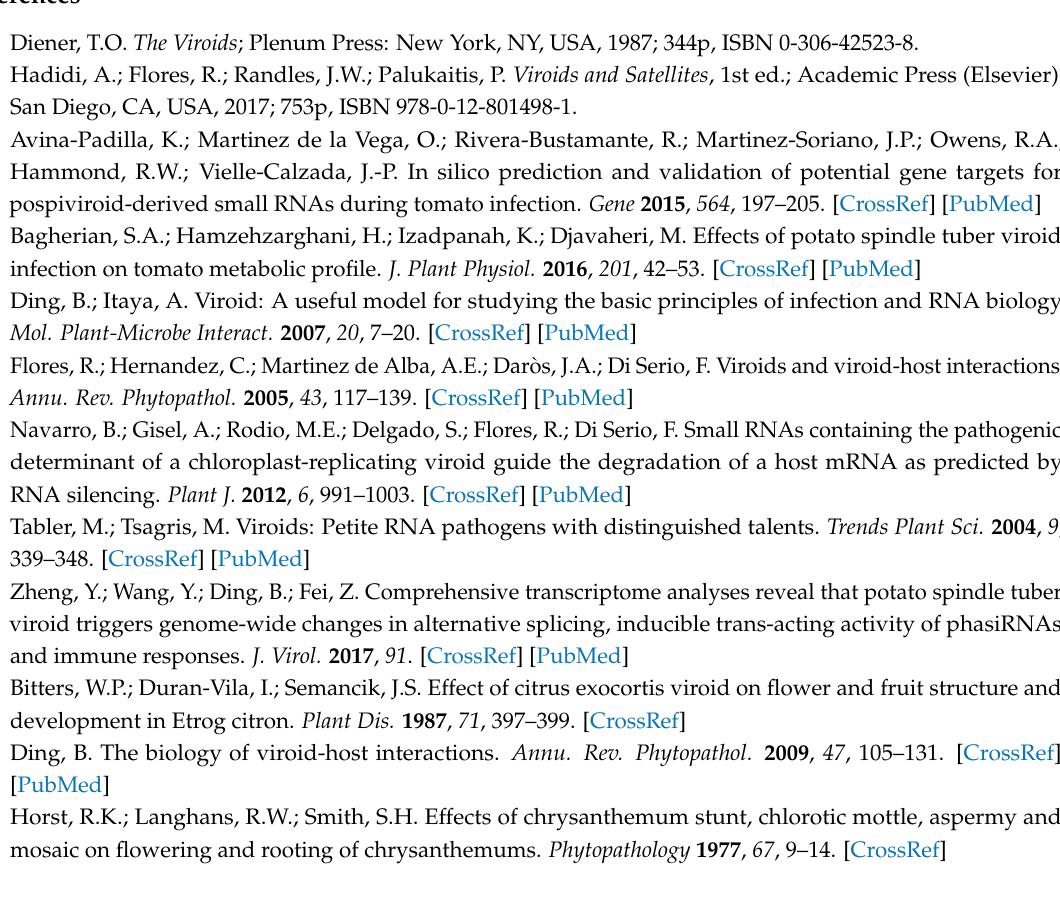
s1, Table S1: Oligonucleotide primer sets used in RT-PCR, real-time and stem-loop RT-PCR analyses. Table S2. List of network components shown in Figure S2. Figure S1: Rod-like secondary structures of TPMVd and the OG1 strain of MPVd. Figure S2: Description of components of the predicted network association of